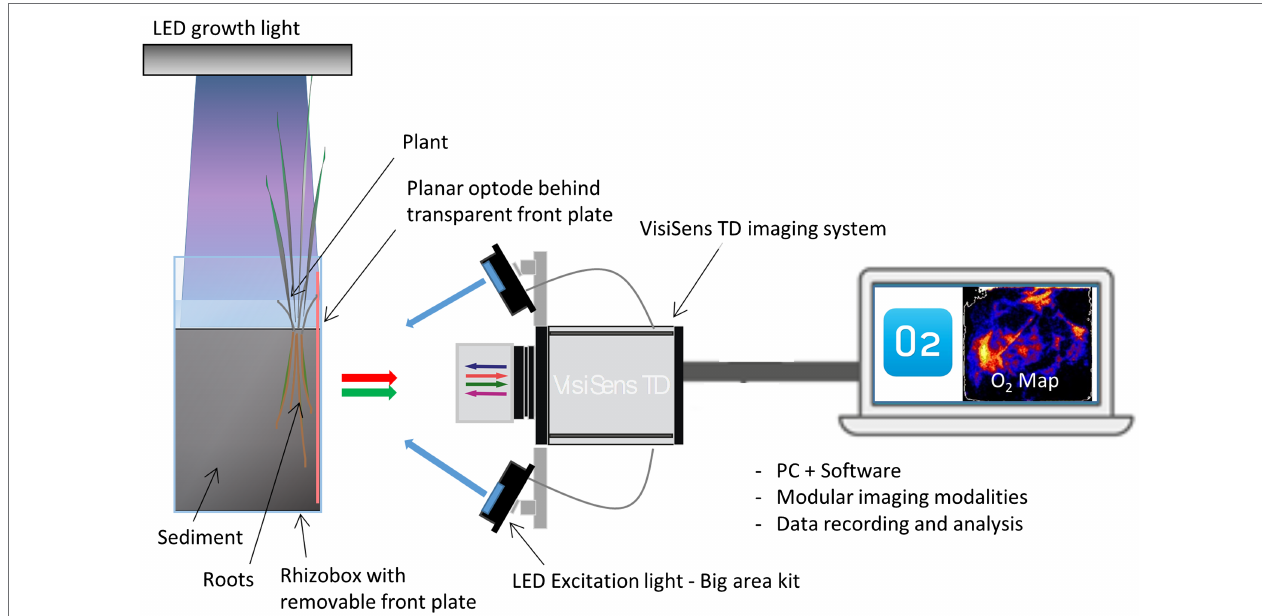
FIGURE 1 | Experimental setup for planar optode investigations of rhizosphere processes with the planar optode system VisiSens TD. A rhizobox with sediment and the sample plant is equipped with a planar luminescent O 2 sensor foil. The aboveground biomass of the plant is illuminated in a day–night cycle with a LED growth light. The O 2 dependent signals of the sensor foil are read out with the VisiSens camera detector under excitation with specific blue excitation light. The recorded signals are transformed into 2D O 2 maps via the camera